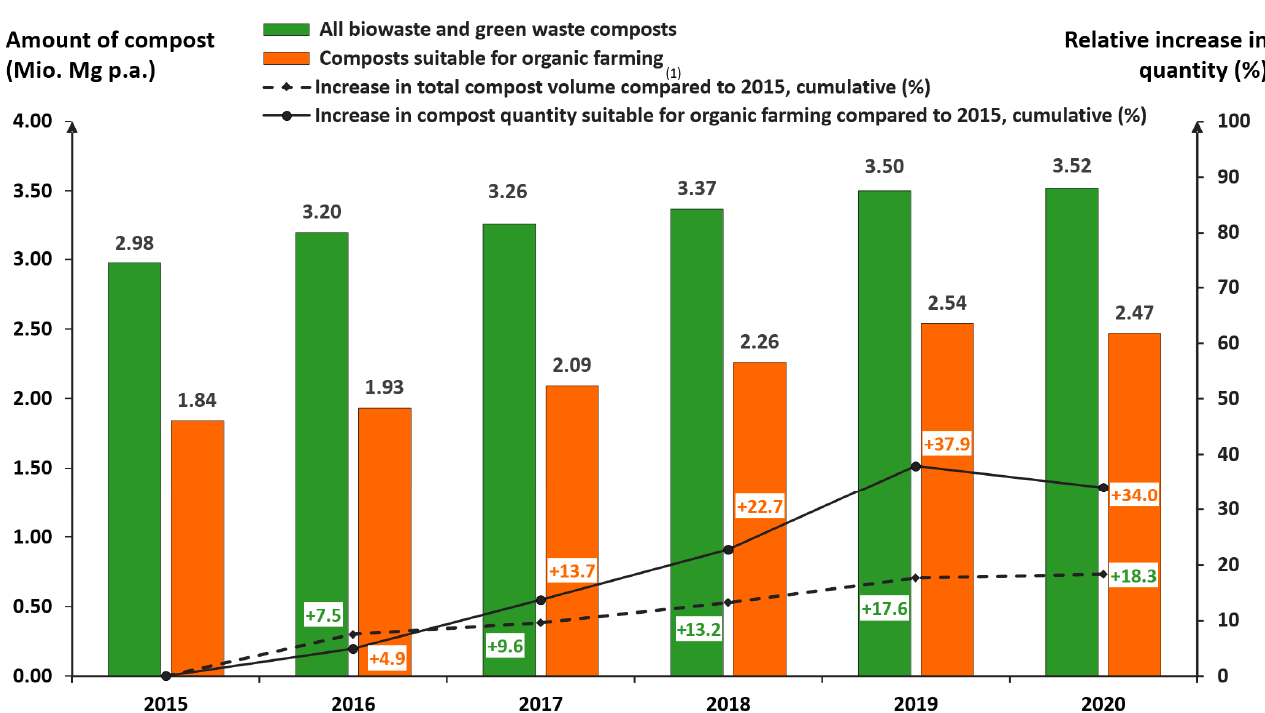
Figure 9. Development of the volume potential of quality-assured biowaste and green waste composts for organic farming in Germany in 2015–2020 (composts according to RAL-GZ 251 Compost of BGK in Germany in 2015–2020). (1) Limit values ( ≤ ) according to EU-ÖkoV—EU Regulations on organic farming (Regulation (EC) No. 889/2008, Annex 1 resp. 2021/1165, Annex 2; guideline values ( ≤ ) according to Bioland/Naturland guidelines (5/2014 to 3/2020).